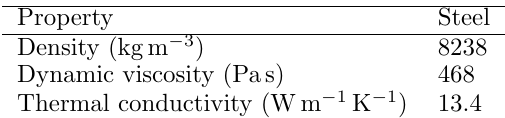
Table 4. Thermo-physical properties of steel [7]. Property